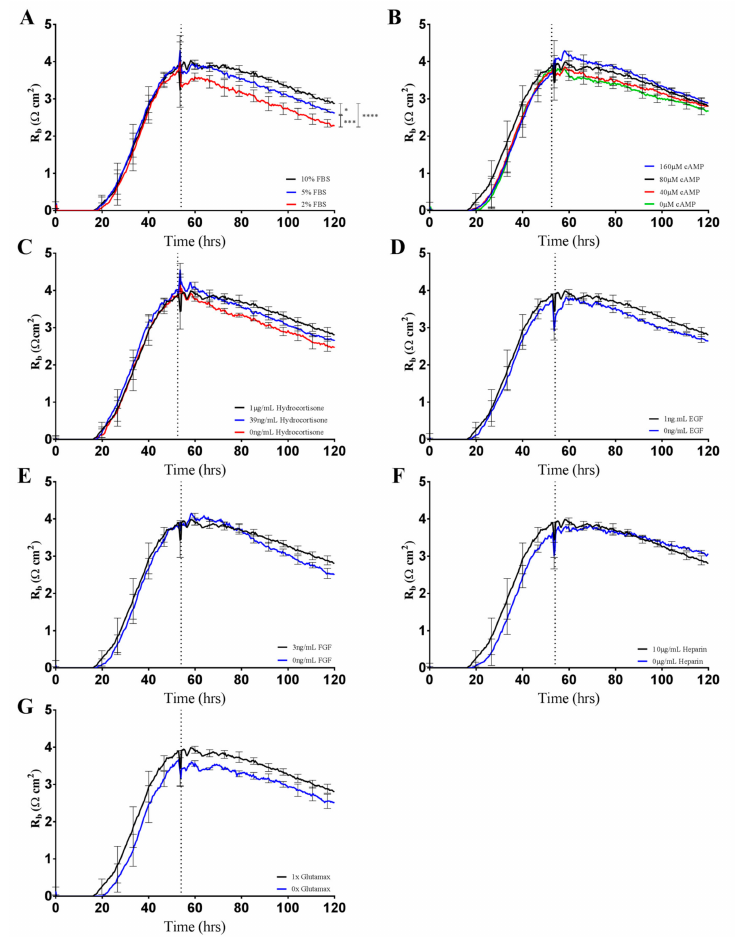
Figure 5. Changes in R b as a consequence of altering growth medium components as shown by brain endothelium. Endothelial cells were seeded at 20,000 cells per well on a 96w20idf ECIS array. Time 0 h denotes the time cells were seeded. The dotted vertical line indicates 48 h of cell growth in each respective media type, with a subsequent media change carried out at this time. ( A ) Brain endothelium grown in Enriched Media containing either 10%, 5%, or 2% FBS; ( B ) Brain